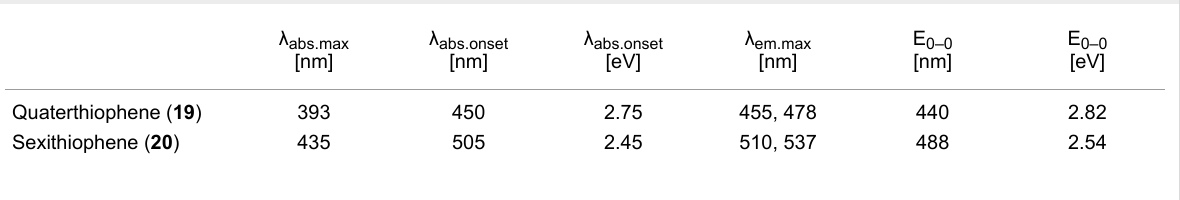
Table 2: Spectral data of oligothiophenes in CH 2 Cl 2 .